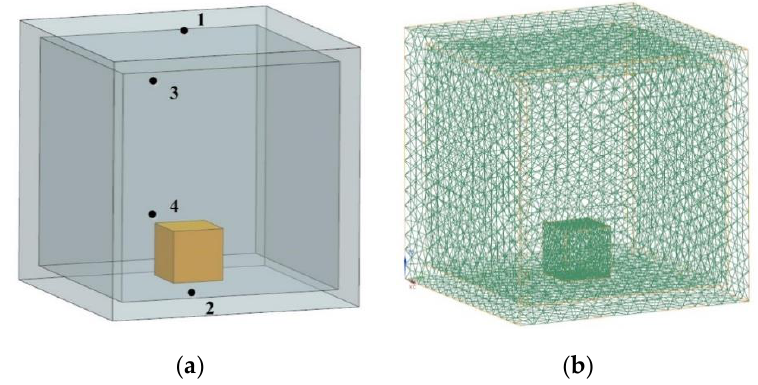
Figure 8. The box structures: ( a ) Entity model; ( b ) Finite element model.